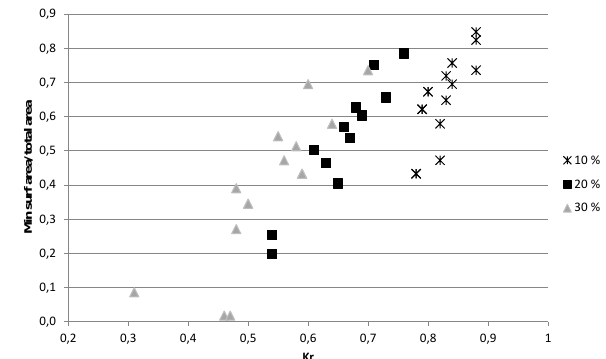
Figure 4. Relationship between minimum surface area and K r for different R v